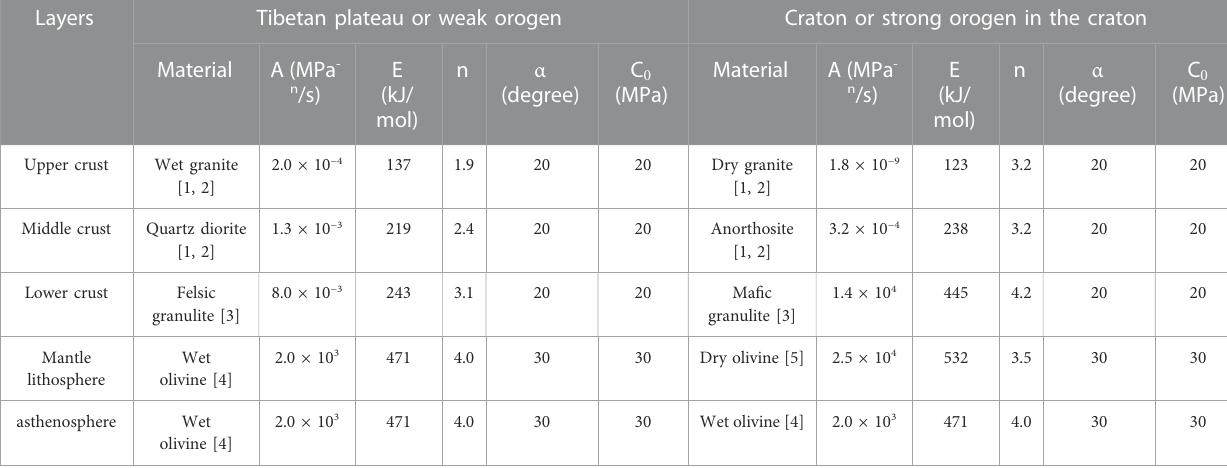
TABLE 1 Rheological parameters of the numerical models a .